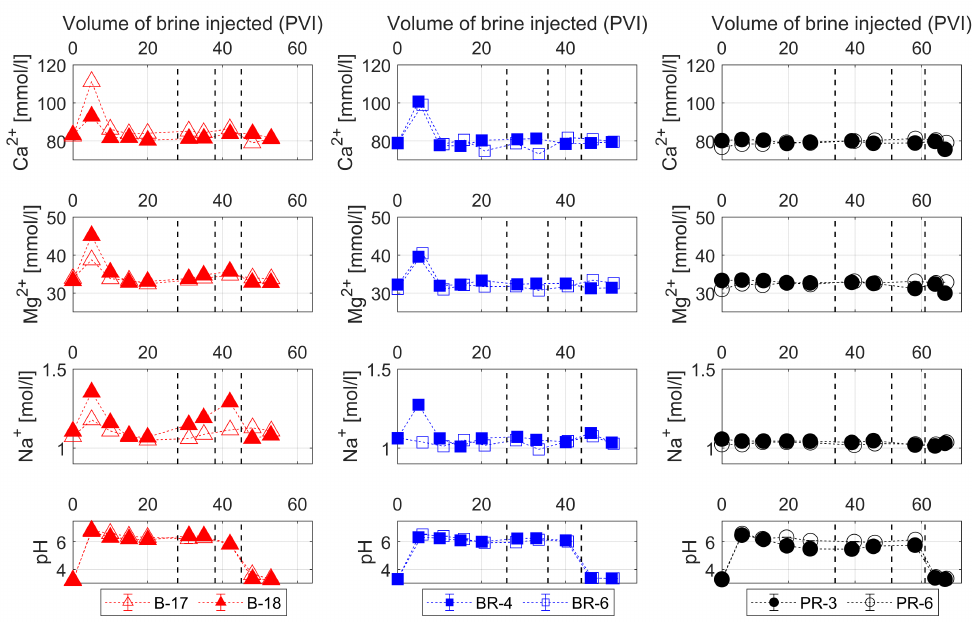
Figure 6. Ionic concentration and pH changes in the effluents collected during the flooding test with 2D*TB EDTA . In this plot B-17 and B-18 are homogeneous rocks (Berea sandstone); BR-4, BR-6, PR-3, and PR-6 are heterogeneous rocks (Bandera Brown and Parker